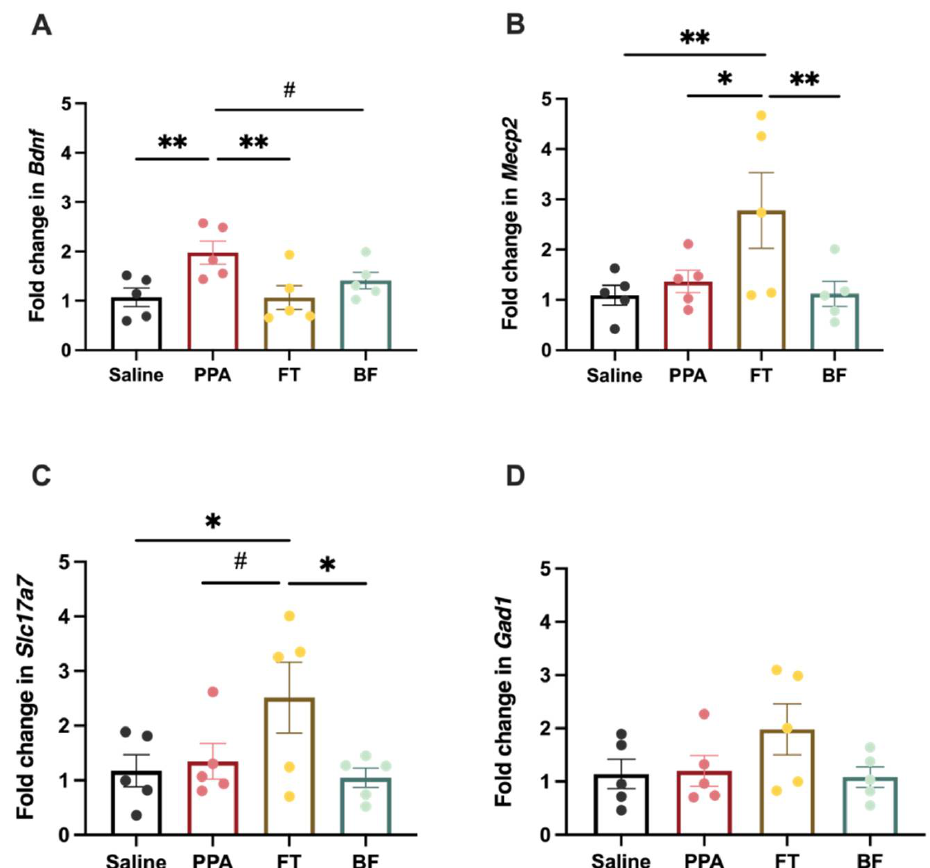
Figure 5. Fold change in hippocampal transcript levels following saline ( n = 5) and propionic acid (PPA) ( n = 5) treatments, and fecal transplant (FT) ( n = 5) and Bifidobacterium (BF) ( n = 5) interventions: ( A ) brain-derived neurotrophic factor ( Bdnf ); ( B ) methyl-CpG binding protein 2 ( Mecp2 ); ( C ) solute carrier family 17, member 7 ( Slc17a7 ); ( D ) glutamate decarboxylase 1 ( Gad1 ). Data presented are means ± standard error of 2 − ∆∆ Ct values. Significant one-way ANOVA was followed by multiple comparisons by Fisher’s least significance difference ** p ≤ 0.01, * p ≤ 0.05, # p =